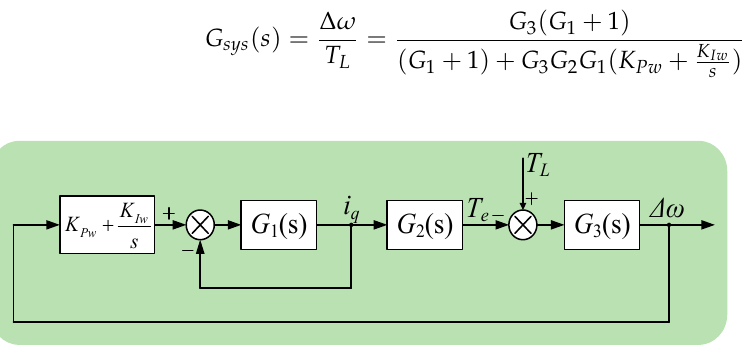
Figure 8. The transfer function of rotating speed.